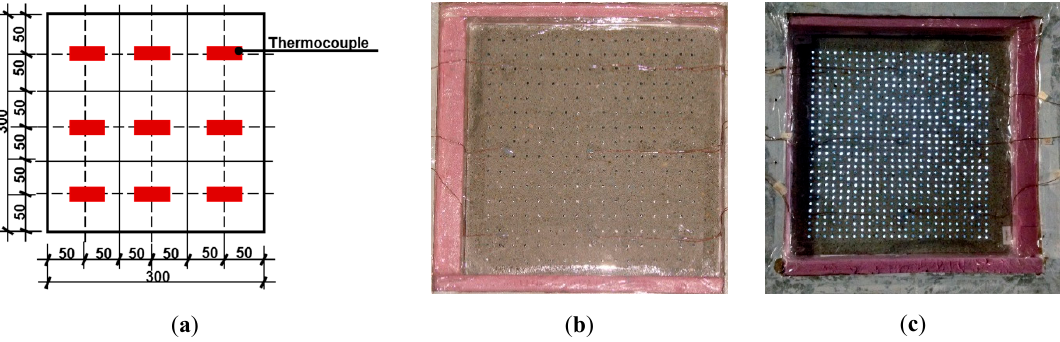
Figure 6. Installed specimen and thermocouples: ( a ) layout of the thermocouples; ( b ) view from outdoor side; ( c ) view from indoor side.